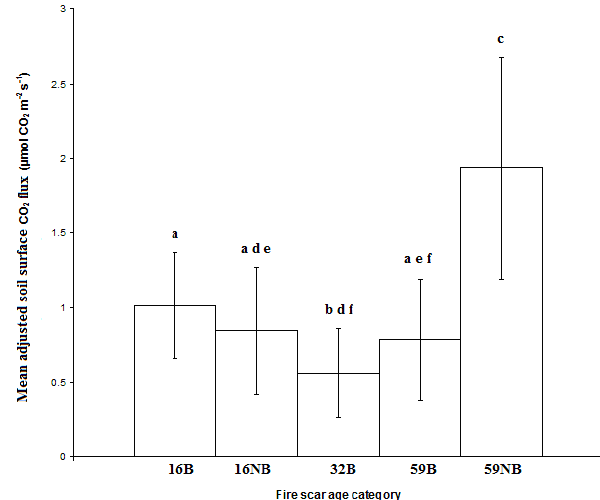
Fig. 2. Mean soil surface CO 2 flux adjusted for soil temperature for the five fire scar age categories at Sharpsand Creek. Soil tempera- ture adjustment assumes Q 10 = 2 (dimensionless) and reference soil temperature = 10 ◦ C. Error bars represent ± 1 standard deviation of the mean. Different letters indicate differences at P ≤ 0 .